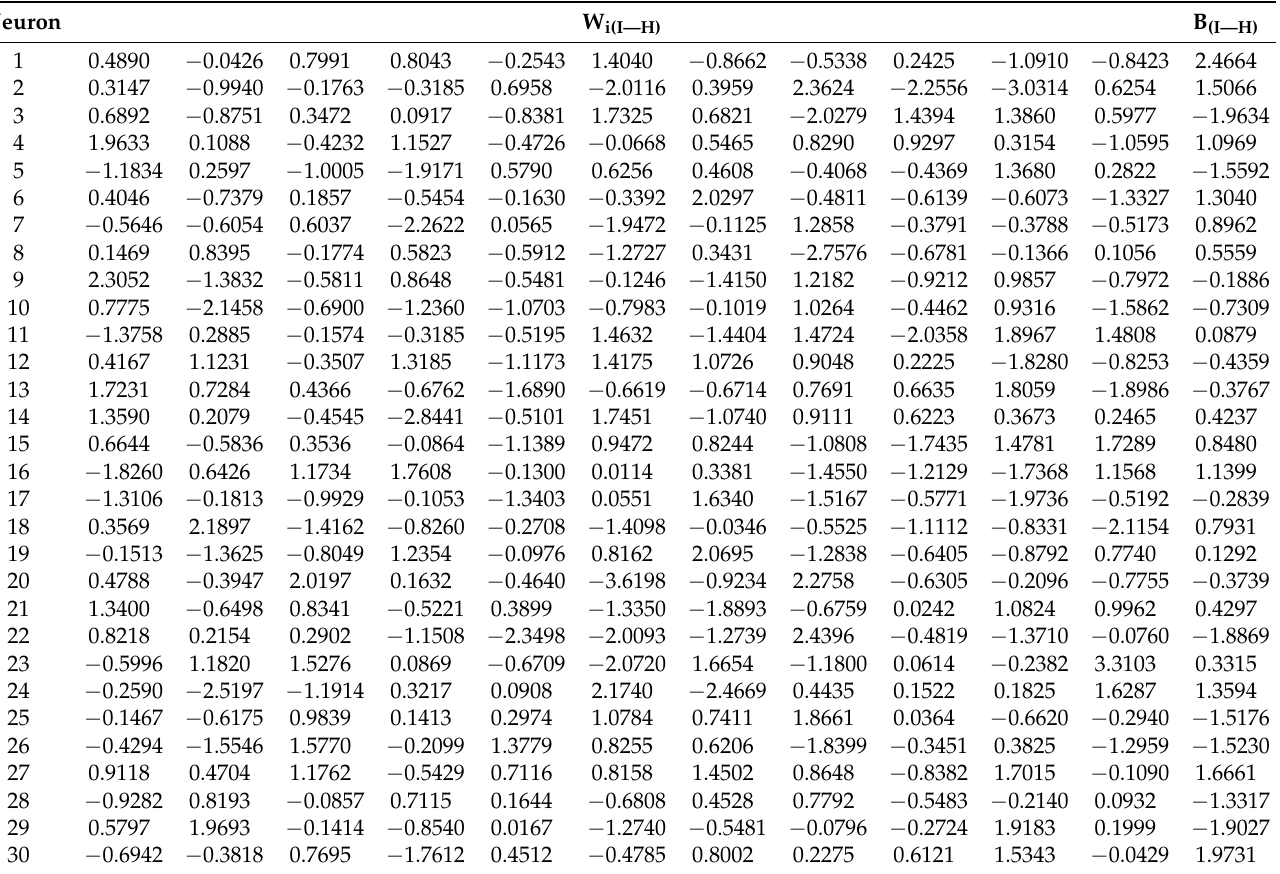
Table 7. Weight and biases of hidden